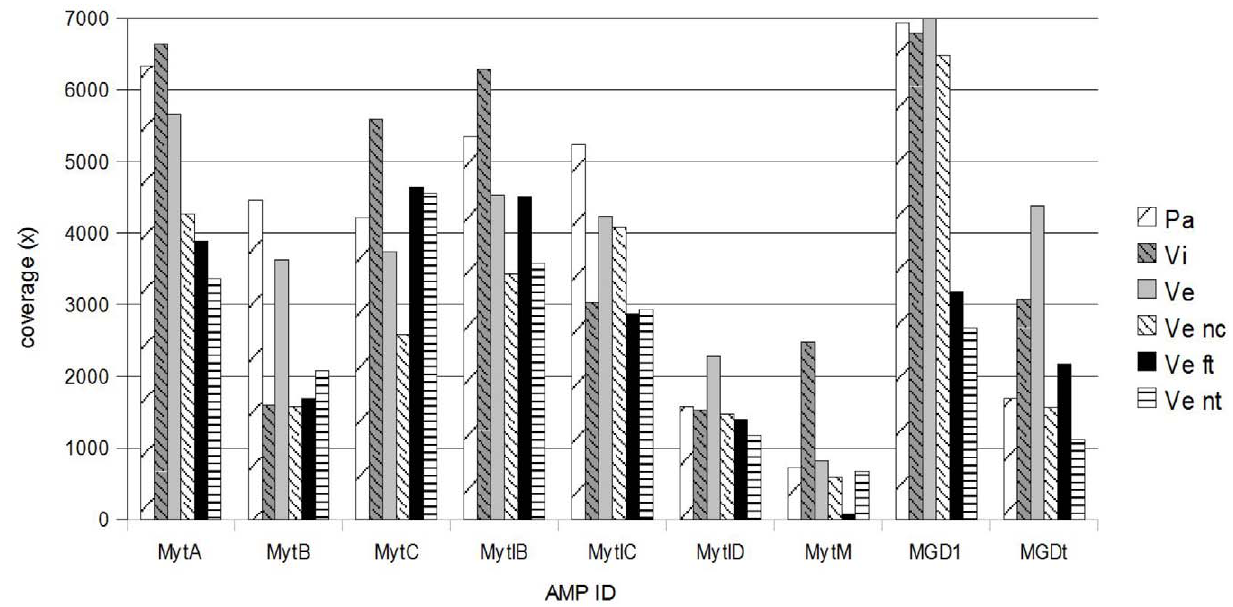
Figure 1. Average base coverage (x) per AMP and sample. Coverage is calculated as total sequenced base divided by the length of the amplified transcript.